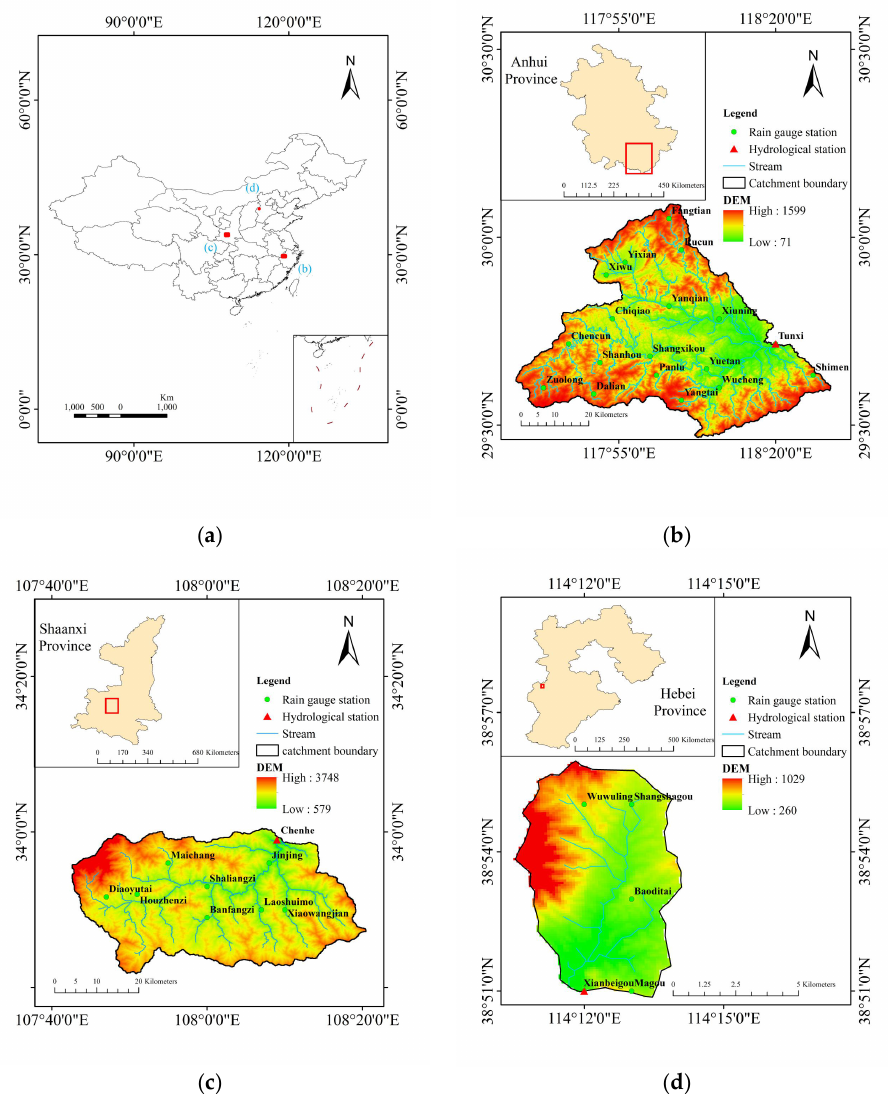
Figure 1. Locations, elevations and river networks of the study areas: ( a ) their locations in China, ( b ) Tunxi Catchment, ( c ) Chenhe Catchment, and ( d ) Xianbeigou Catchment.